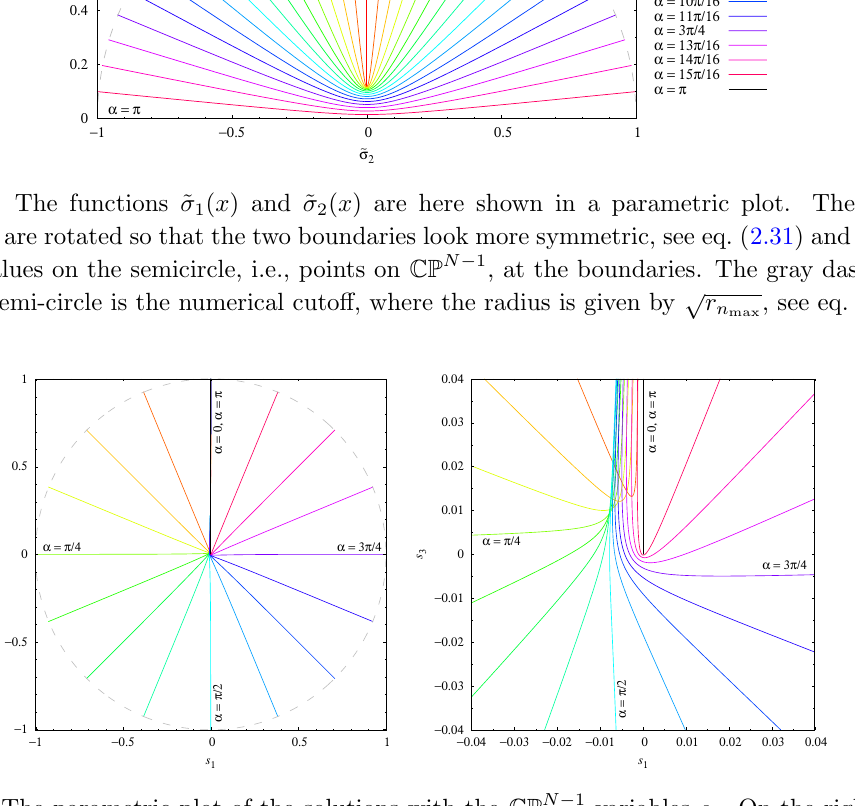
Figure 6. The parametric plot of the solutions with the CP N (cid:0) 1 variables s i . On the right is the zoomed-in picture of the same curves. The gray dashed circle is the numerical cuto(cid:11), where the radius is given by r n , see eq. (3.6). The colors are shown in the legend of (cid:12)gure max